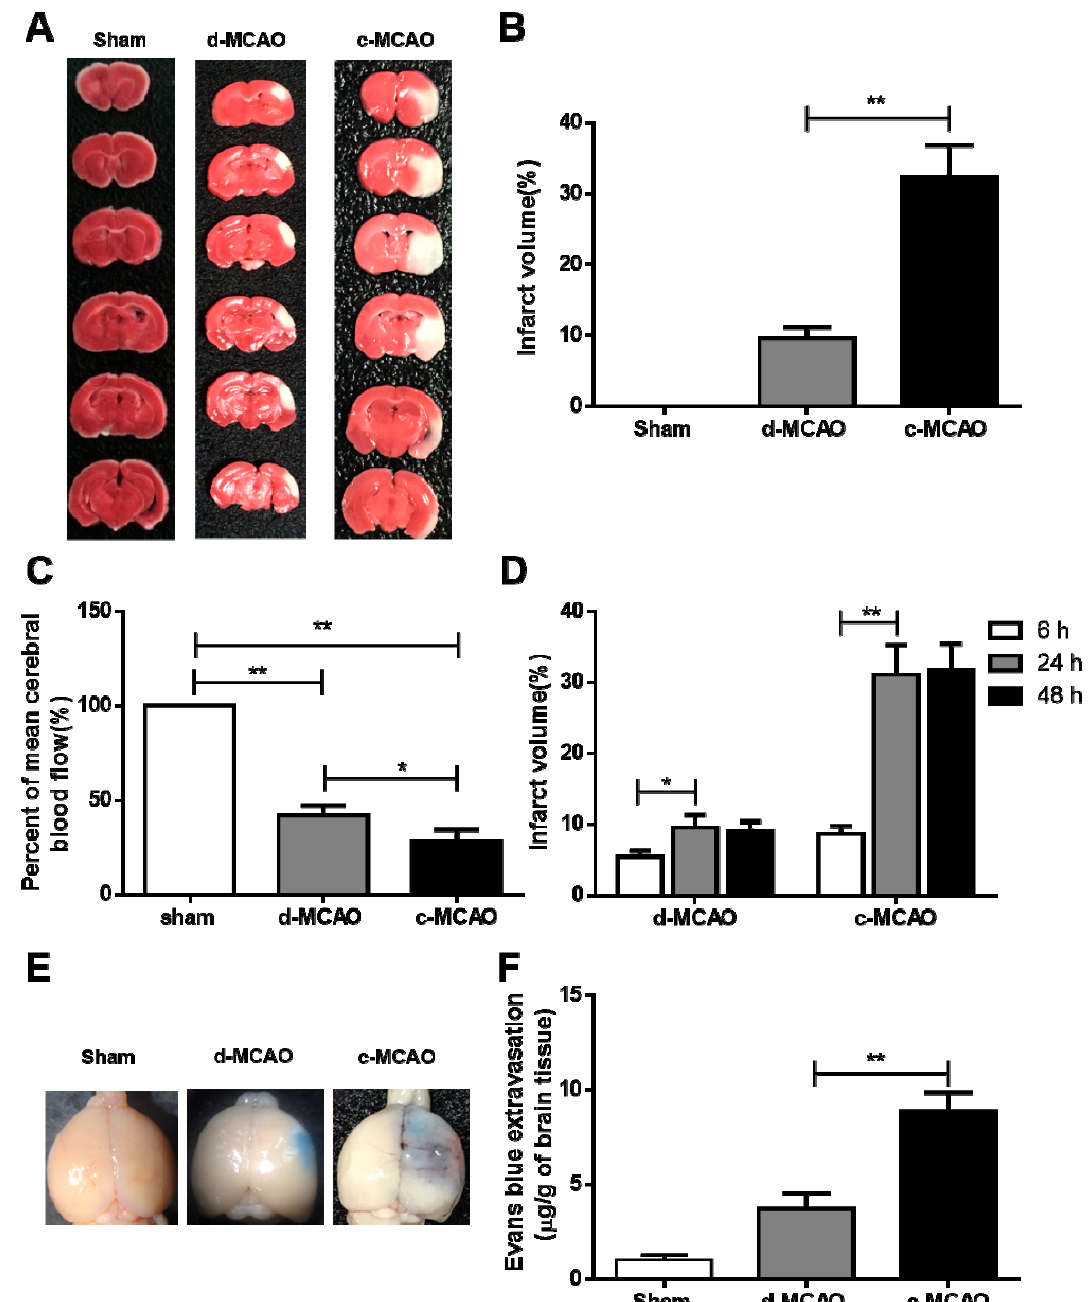
Figure 2. Comparison of the severity of ischemic strokes induced by d-MCAO and c-MCAO. Wild-type (WT) hamsters were subjected to d-MCAO and c-MCAO for 24 h.( A ) Representative images of six coronal brain sections stained with 2, 3, 5-triphenyltetrazolium chloride (TTC) staining. ( B ) Quantification of the infarct volumes in Sham, d-MCAO, and c-MCAO from ( A ) ( n = 6/group). ( C ) Measurement of cerebral blood flow after ischemia by laser Doppler transducer ( n = 6–8/group). ( D ) Time course analysis of infarct volume in ischemic hamsters induced by d-MCAO and c-MCAO ( n = 6–8/group). ( E ) Representative images of the Evan’s blue (EB)-stained whole brains in sham, d-MCAO, and c-MCAO group. ( F ) Quantification of the Evan’s blue extravasation; data are expressed as mean ± SD. * p < 0.05; ** p < 0.01 versus sham group.